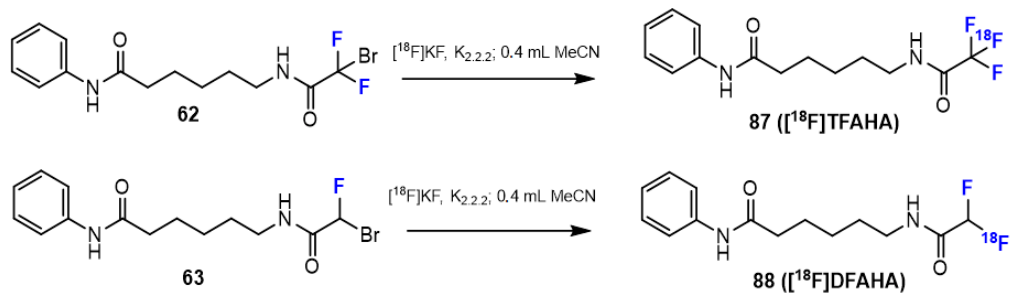
Scheme 22. Fluorination in the radiosynthetic pathway of fluorinated benzamides by Bonomi et al.